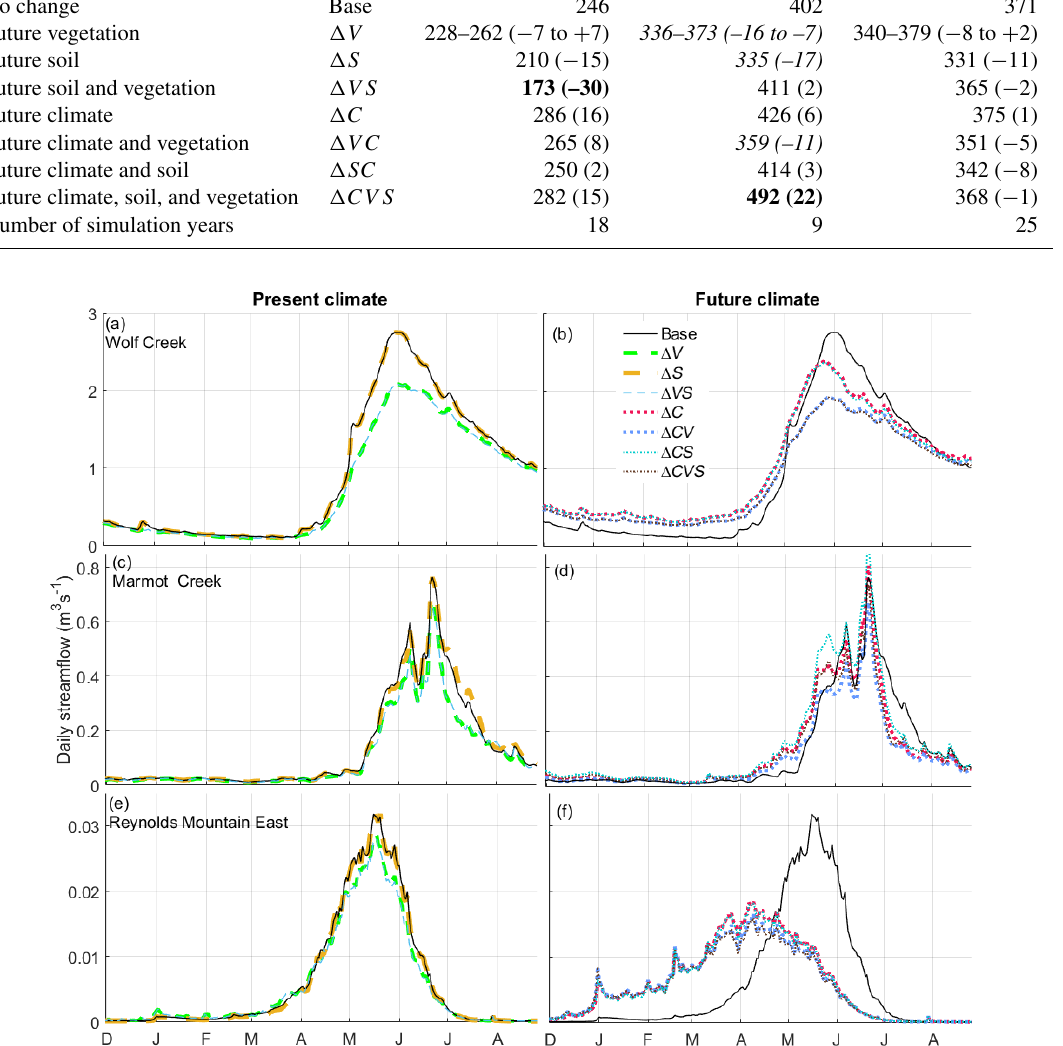
Figure 9. Annual average hydrographs under present climate, present vegetation, and present soil (base); present climate, future vegetation, and present soil ( (cid:49)V ); present climate, present vegetation, and future soil ( (cid:49)S ); present climate, future vegetation, and future soil ( (cid:49)V S ); future climate, present vegetation, and present soil ( (cid:49)C ); future climate, future vegetation, and present soil ( (cid:49)CV ); future climate, present vegetation, and future soil ( (cid:49)CS ); and future climate, future vegetation, and future soil ( (cid:49)CV S ) in the three